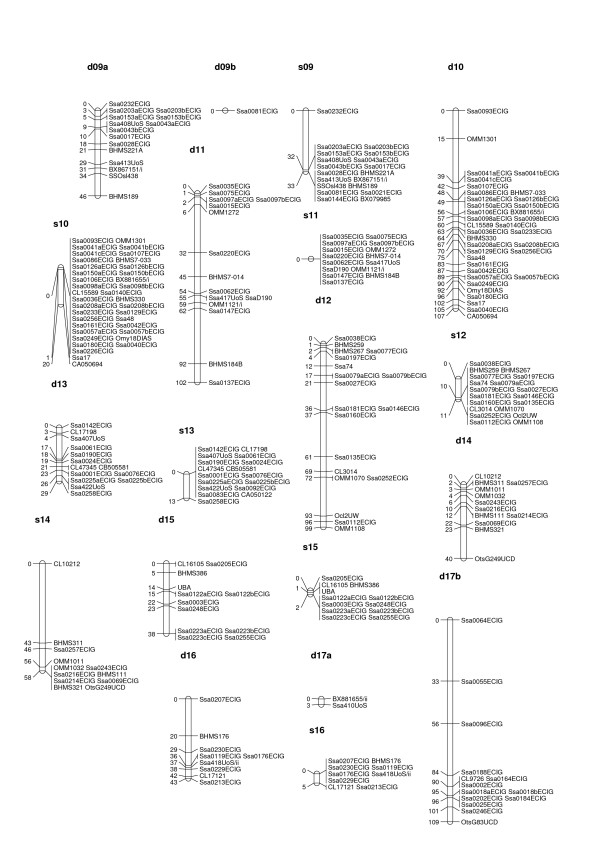
male and female linkage maps for Atlantic salmon (linkage groups d09a to s17b). Male and female linkage groups have prefixed s- and d-respectively. The linkage group nomenclature (numbers) is the same as in the map developed by the SALMAP project [15], except for one linkage group (sA/dA) that contains no markers present on the SALMAP map. The map units are Kosambi cM.